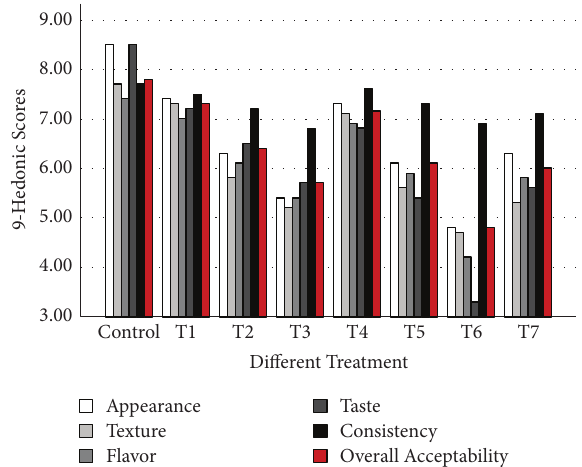
Figure 4: Estimated marginal means for sensory evaluation in functional yogurt samples were conducted and textured to ease in